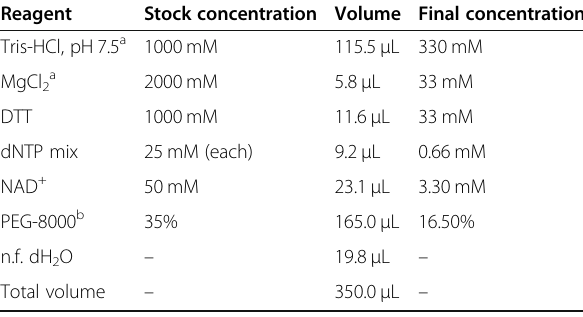
Table 2 GA reaction buffer (3.33×, 350 μ L)